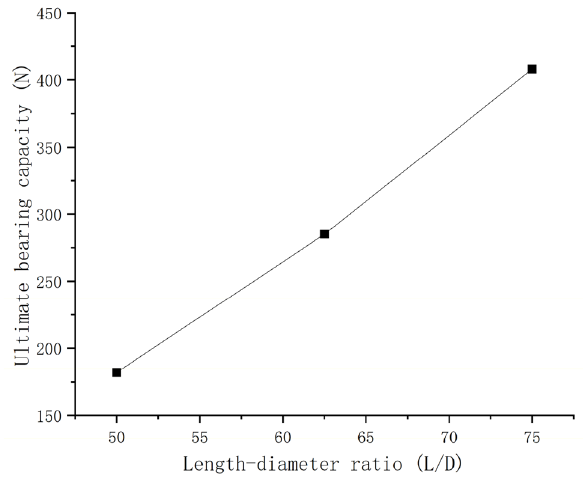
Figure 10. Relationship between Ultimate bearing capacity and length-diameter ratio.